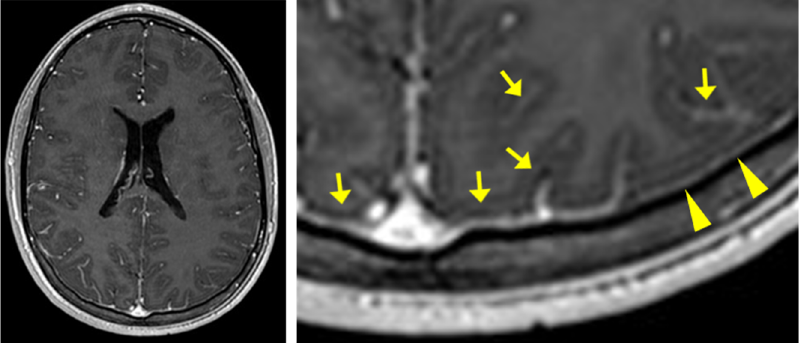
Figure 2. cMRI with a gadobutrol-enhanced T1-weighted fastfield echo (T1-FFE) sequence per- formed three days after lumbar puncture showing slight pachy- (arrowheads) and leptomeningeal (arrows) enhancement.